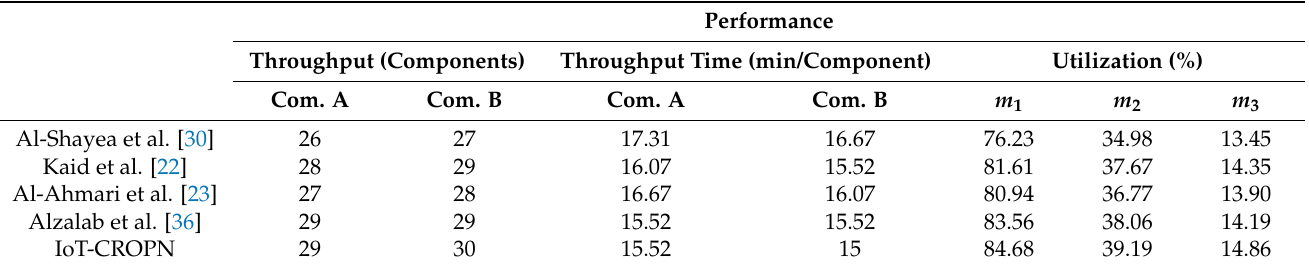
Table 3. Comparison of the proposed IoT-CROPN shown in Figure 11 with existing methods.